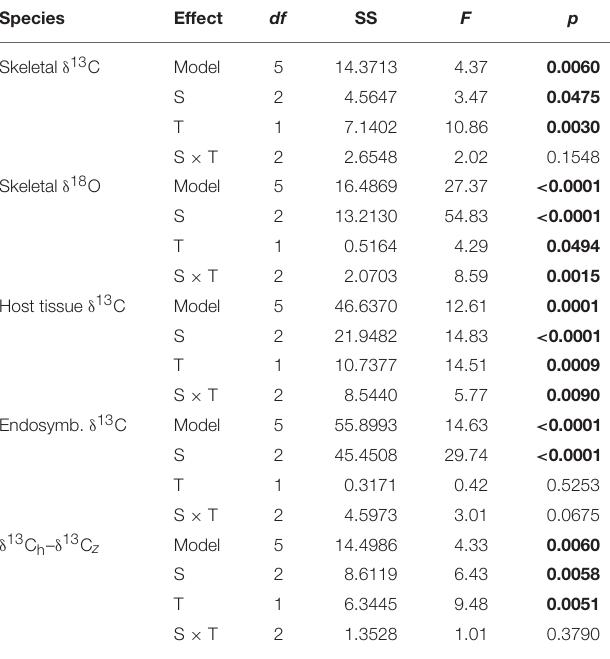
TABLE 3 | Results of five two-way ANOVAs testing for the effect of species (S), and temperature (T) on coral skeletal δ 13 C, skeletal δ 18 O, host tissue δ 13 C, endosymbiontic algal δ 13 C, and the difference between host and endosymbiontic algal δ 13 C ( δ 13 C h – δ 13 C z ).